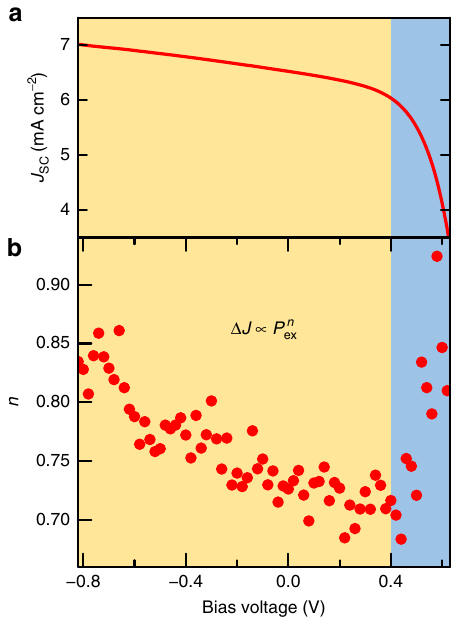
Fig. 2 Bias voltage dependence of two-step photon up-conversion properties at 297K. a Short-circuit current density ( J SC ). b n value of Δ J Δ J SC is the change in the short-circuit current density, and excitation power density. The wavelength and excitation power density of the fi rst interband excitation light were 780 nm and 110 mWcm − 2 , respectively. P ex was varied in the range 1 – 320 mW cm −